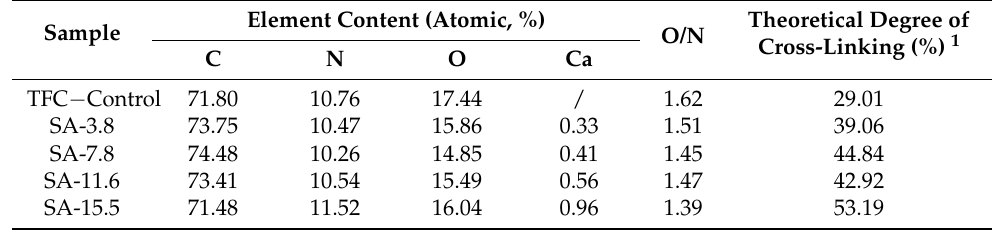
Table 1. Surface composition of polyamide layer on TFC − Control and SA–TFC